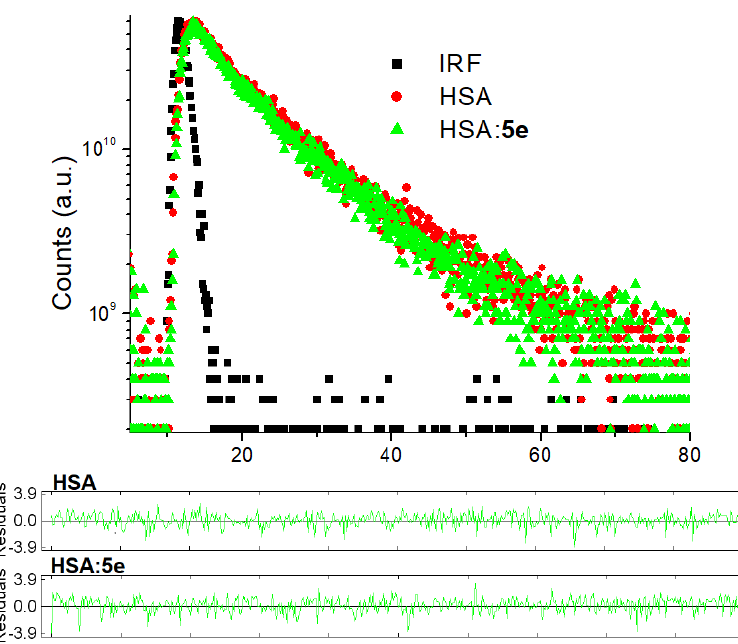
Figure 5. Time-resolved fluorescence decays for human serum albumin (HSA) without and in the presence of 5e at room temperature and pH = 7.4. [HSA] = 1.00 × 10 − 5 M and [ 5e ] = 2.78 × 10 − 5 M. IRF: Instrument response function.